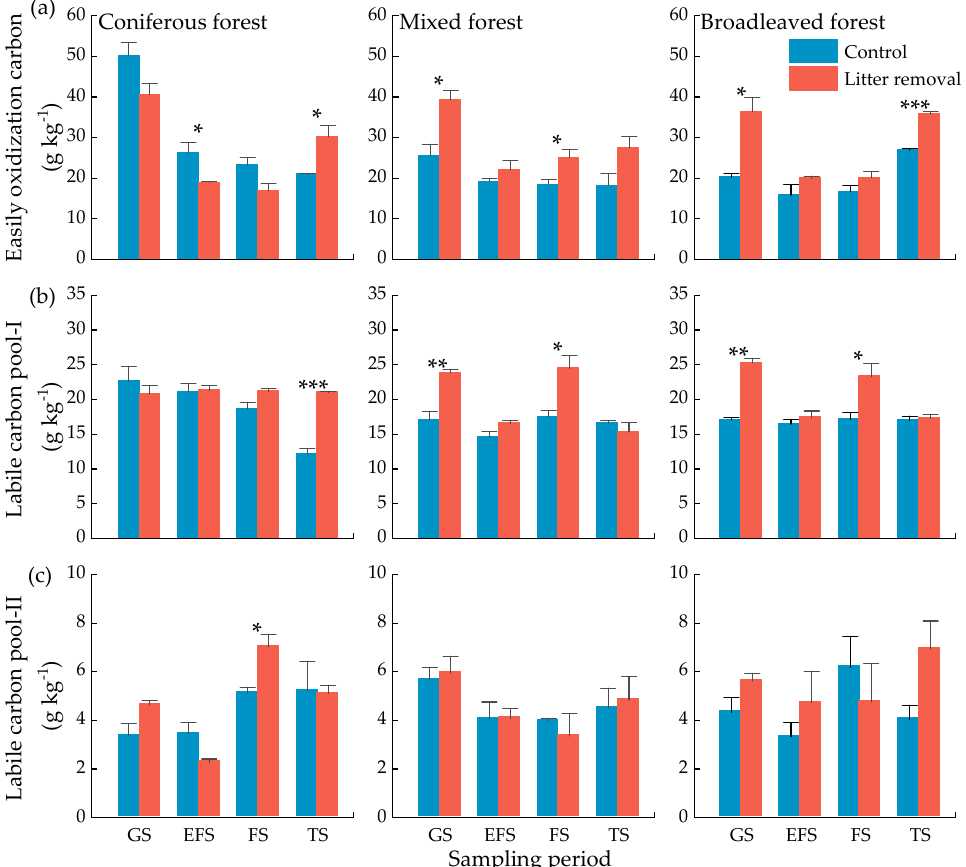
Figure 6. Concentrations of soil active organic C of three forests at different sampling periods. Easily oxidization carbon ( a ), labile carbon pool-I ( b ), labile carbon pool-II ( c ). Values indicate means ± standard error, n = 3. GS: growing season, EFS: early freezing season, FS: freezing season, TS: thawing season. Asterisks indicate significant differences between the two treatments in same forest type at the same season. * p < 0.05, ** p < 0.01, *** p < 0.001.